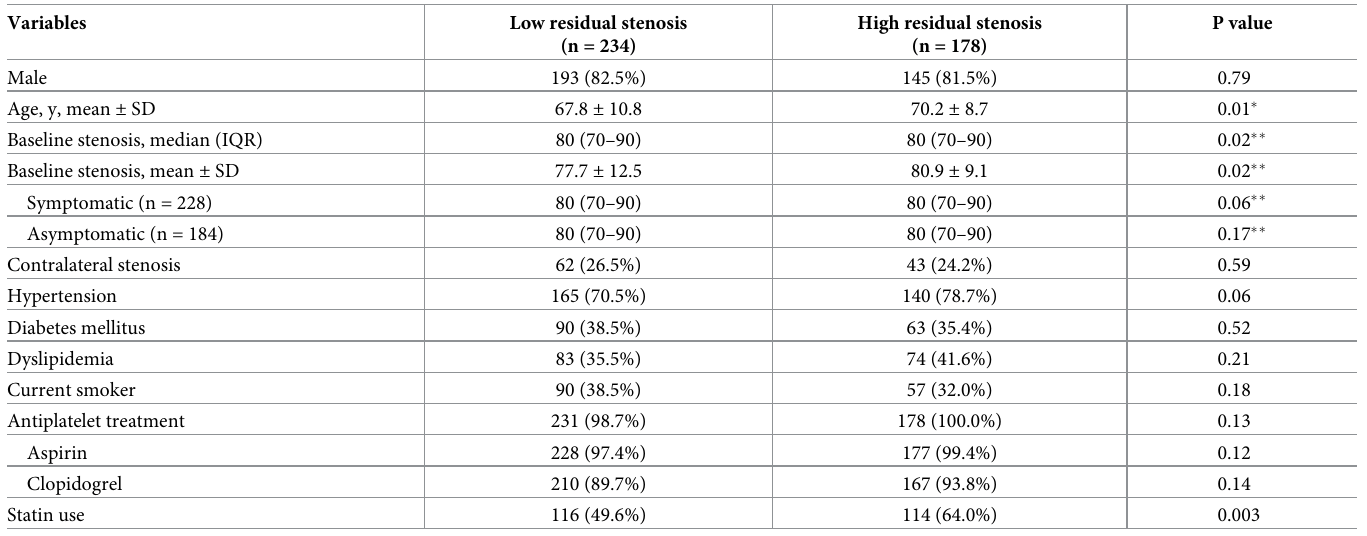
Table 1. Comparisons of baseline characteristics according to residual stenosis